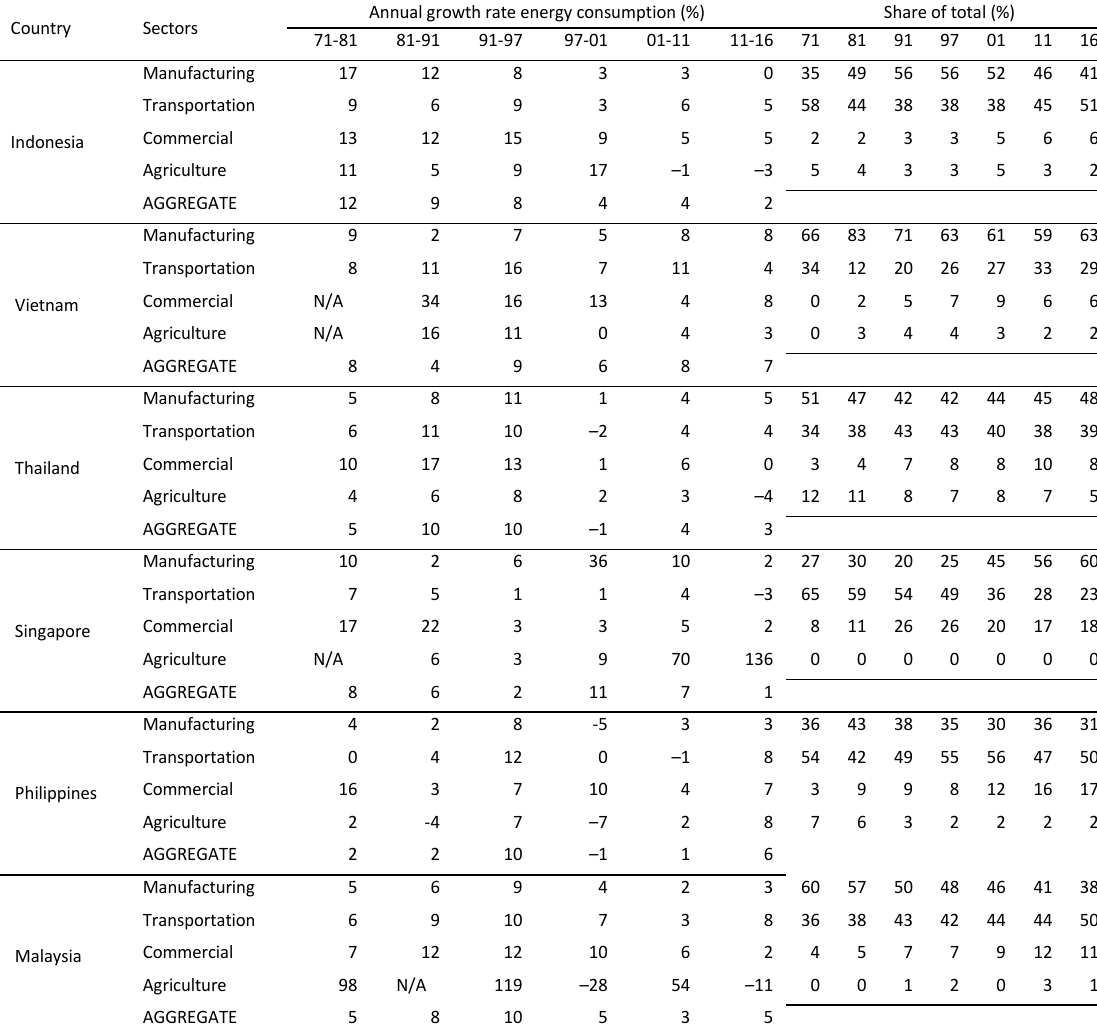
Table 2. Energy Consumption shares and annual growth rate of